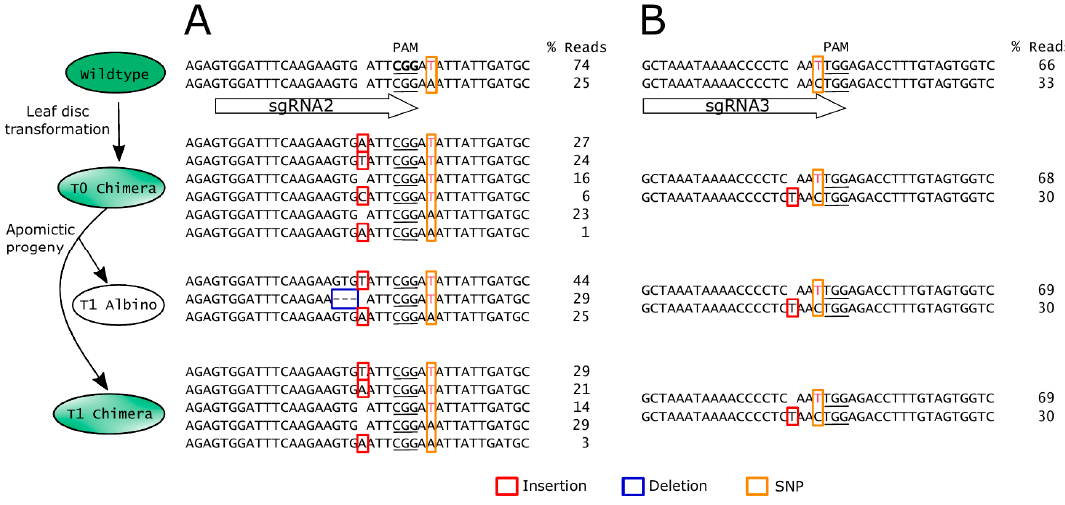
Figure 5. Stability of edits in the HPDS gene across different generations of apomictic Hieracium is affected by polymorphisms in the guide RNA. A subset of amplicon deep sequencing results surrounding the ( A ) sgRNA2 and ( B ) sgRNA3 binding sites. For clarity, sequences around the sgRNA3 binding site in ( B ) are shown as reverse complement. For each generation and each sgRNA target site, the allelic sequences from one representative plant are shown. Allele frequencies are shown as percentage of total reads. Note that sgRNA2 was 100% complementary to all alleles detected in the wildtype, but sgRNA3 was only 50% complementary due to a natural SNP 1 base upstream of the PAM. SNPs are shown in colored font with yellow boxes. Indels are shown as red boxes (insertion) or blue boxes (deletion). PAM underlined.